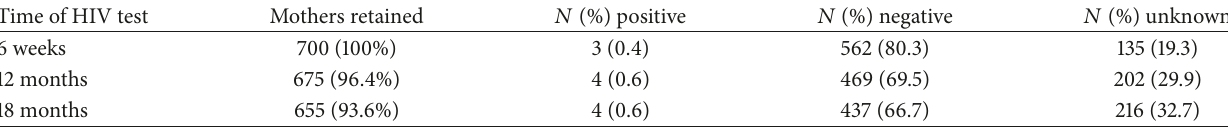
Table 2: Number and proportion of mother retained in care and results infants tested for HIV at 6 weeks and 12 and 18 months after delivery. Time of HIV